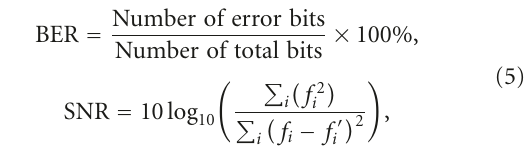
Figure 7: (a) Original watermark and (b) permuted